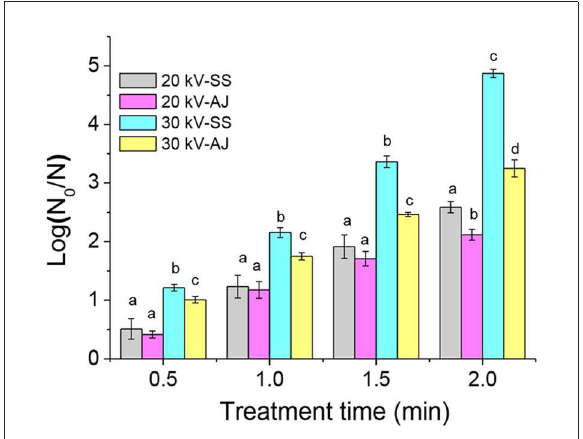
FIGURE1 Inactivation of A. acidoterrestris by DBD-plasma at 20 kV and 30 kV on apple juice (AJ) and 0.85% sterile saline solution (SS). Different letters (a–d) on the top of the bars denote significant differences ( p < 0.05).